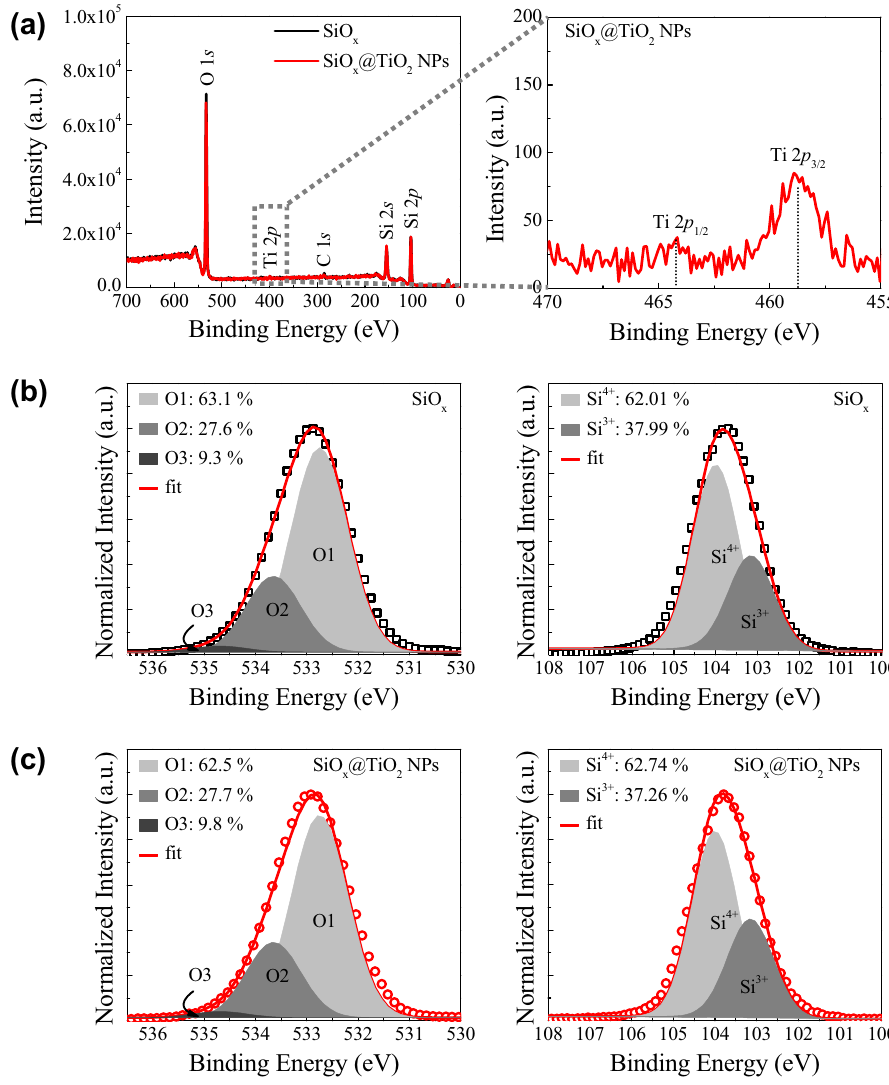
Figure 2. ( a ) XPS survey (left), and the enlargement of Ti 2 p range (right), for the SiO x @TiO 2 NPs. Core-level spectra of O 1 s and Si 2 p for the ( a ) SiO x , and ( b ) SiO x @TiO 2